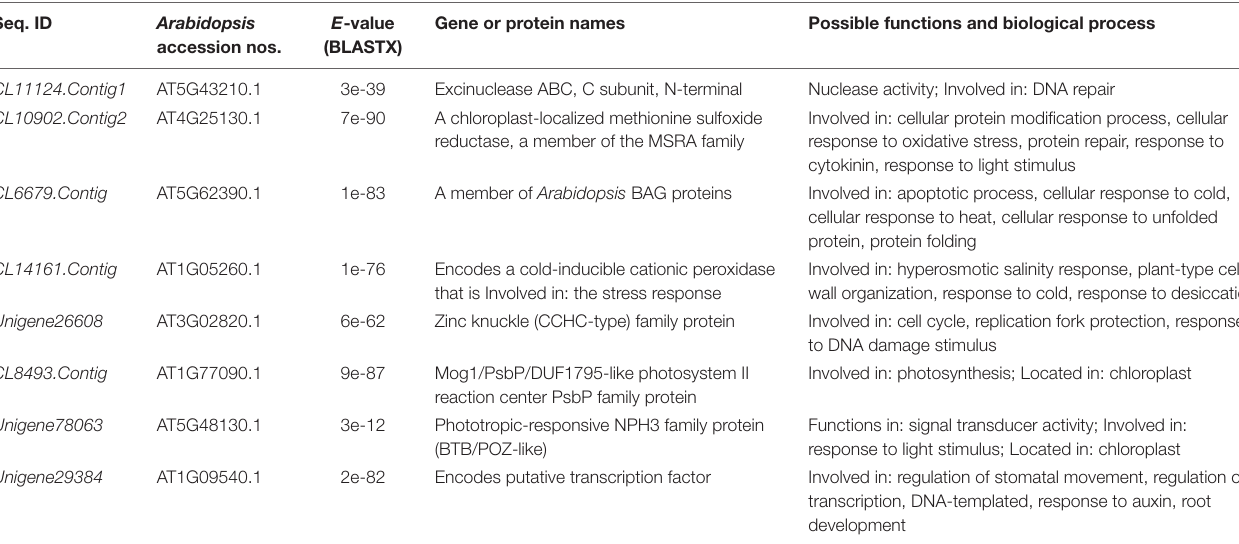
FIGURE 2 | Distribution of dN and dS for the 3,049 pairs of putative orthologous genes estimated using the approximate method with the program yn00 and maximum likelihood method with the program codeml. The pairs with ω > 1 fall above the solid line while those with ω < 0.5 fall below the dashed line. The pairs with dS > 0.1 are not shown. TABLE 2 | Candidate genes for adaptation to different